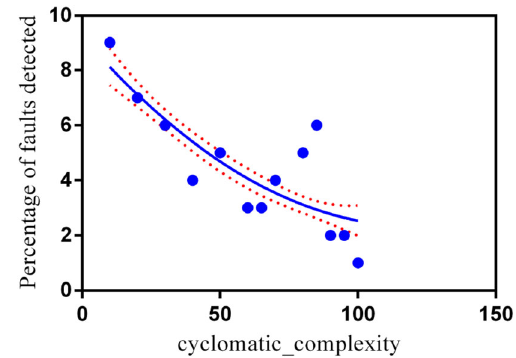
Fig. 5 APFD of greedy algorithm for an arbitrary test suite